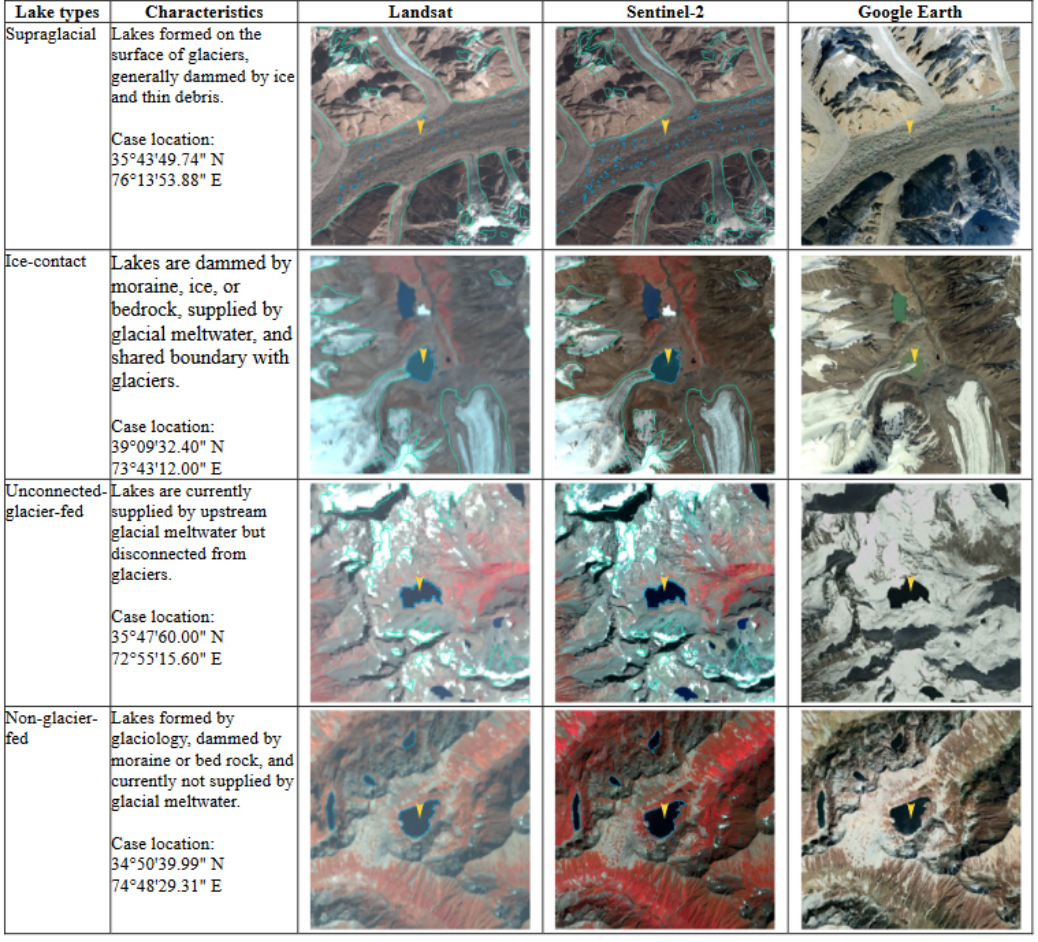
Table 1. A classification system of glacial lake types (GLCS1) according to the relationship between glacial lakes and glaciers (©